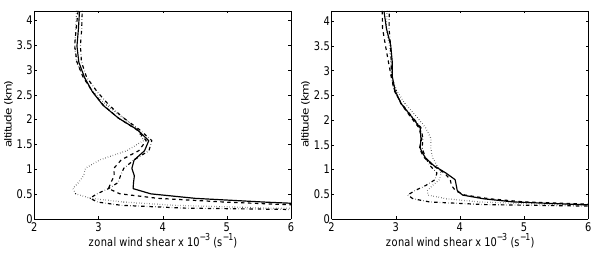
Fig. 11. ECMWF model mean absolute zonal wind-shear (s − 1 ) in the Pacific region 1 (left) and Atlantic region 2 (right) at 0a.m. (dashed), 6a.m. (solid), 12a.m. (dash-dot) and 6p.m. (dot) local time. The mean is taken over the 3-month 2007 winter